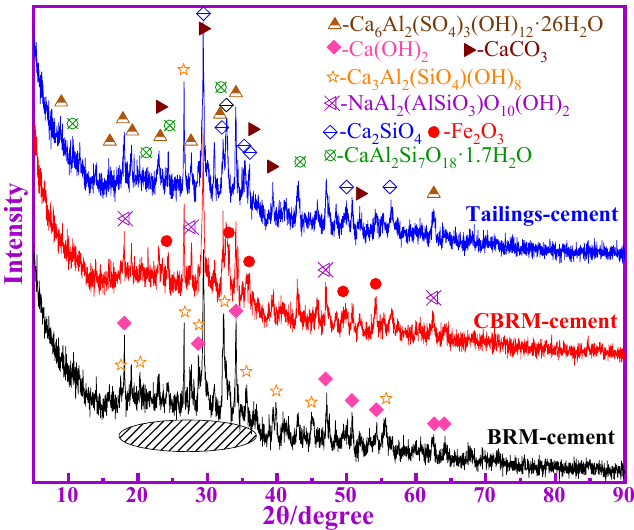
Materials 2021 , 14 , x FOR PEER REVIEW Figure 8. The XRD patterns of BRM-cement, CBRM-cement, and Tailings-cement. Figure 8. The XRD patterns of BRM-cement, CBRM-cement, and Tailings-cement.